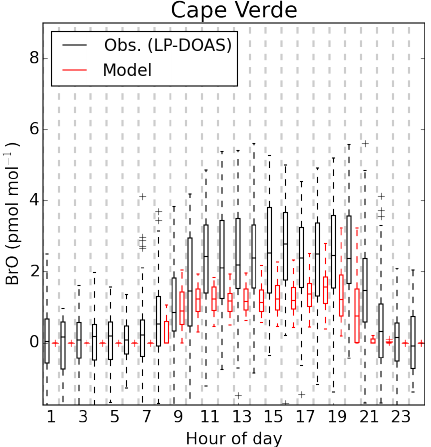
Figure 10. Bromine oxide (BrO) surface observations (black) at Cape Verde (Read et al., 2008; Mahajan et al., 2010) compared against the simulation with halogen chemistry (“Cl + Br + I”, red). Values are binned by hour of day. Locations of observations are shown in Fig. 20.